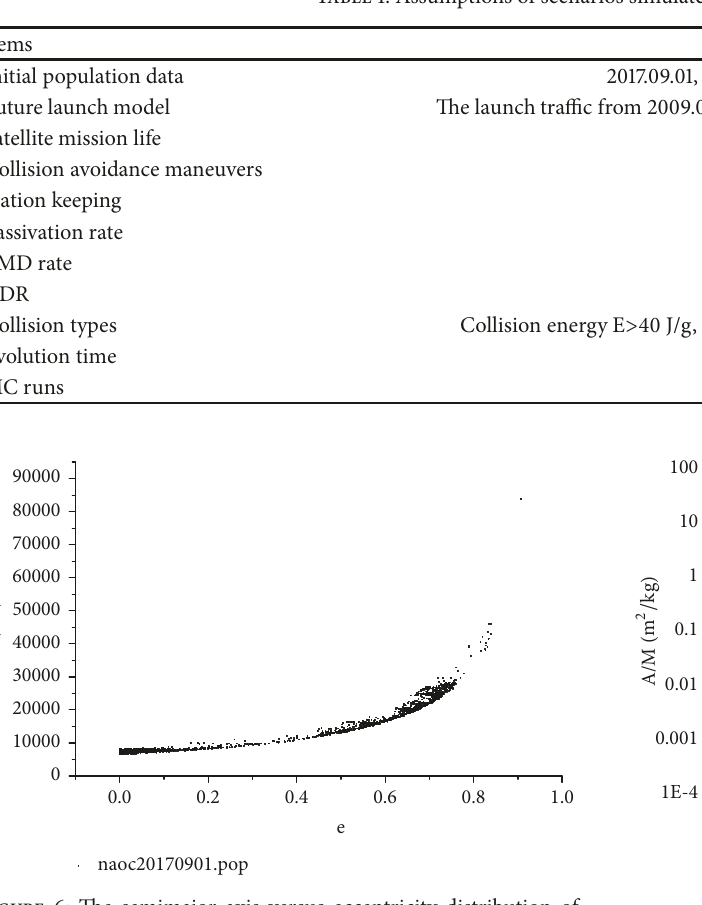
Table 1: Assumptions of scenarios simulated by SOLEM model.